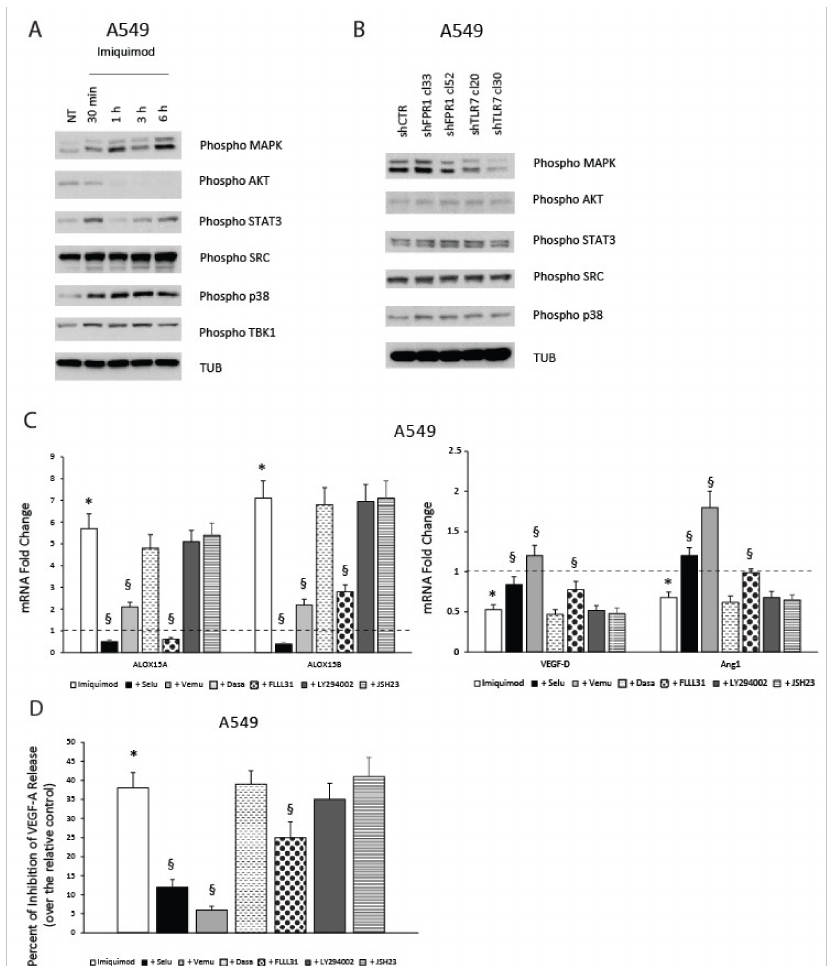
Figure 6. Signaling pathways involved in anti-angiogenic and pro-resolving functions of TLR7. ( A ) Activation kinetics of MAPK, AKT, STAT3, SRC, p38, and TKB1 in A549 cells treated or not for the indicated time points with imiquimod (1 µ g/mL), assessed by Western blot for their phosphorylated forms. α -tubulin (TUB) was used as a